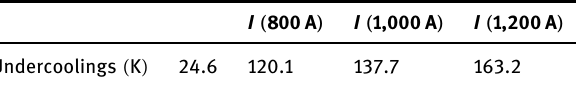
Table 2: Undercoolings of Cu – 37.4 wt% Pb alloys with di ff erent ECP treatments